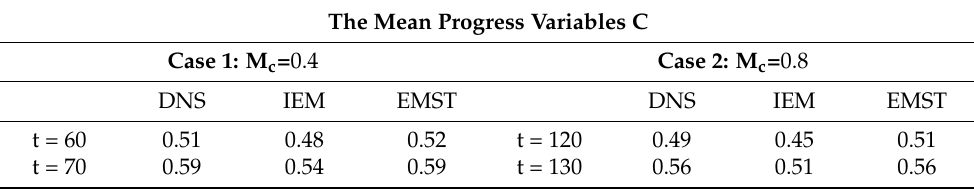
Table 3. Mean progress variables at four moments in DNS, IEM, and EMST simulations in different